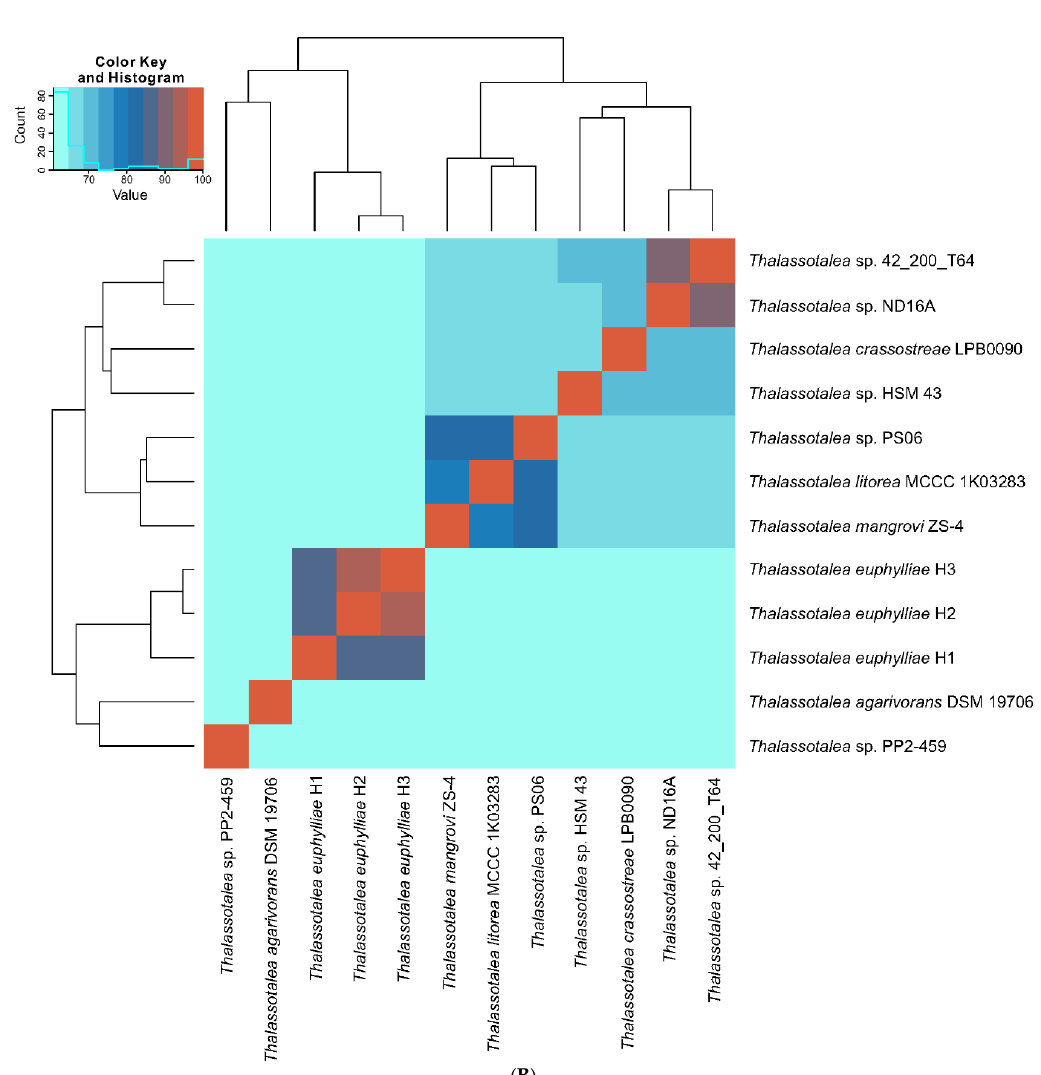
Figure 2. Heatmap of genomic relatedness between PS06 and other members of the genus Thalassotalea . The average nucleotide identity (ANI; ( A )) and average amino acid identity (AAI; ( B )) between pairs of genomes were calculated.